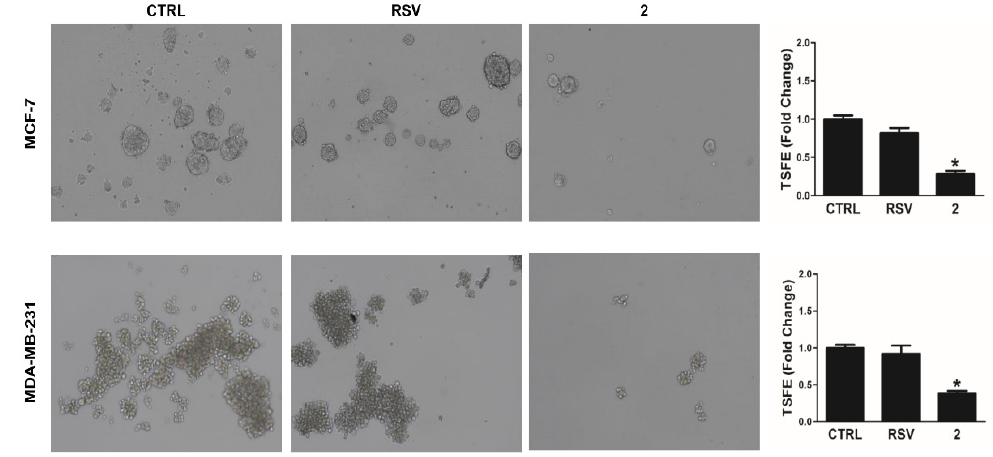
Figure 9. Derivative 2 inhibits breast cancer cell 3D-spheroid formation. MCF-7 and MDA-MB-231 cells were plated on low-attachment plates and then left untreated (CTRL) or treated with derivative 2 ( 2 ) and RSV (20 µM). Spheroid formation capability of untreated and treated cells was determined in a 3D spheroid assay as described in “Materials and Methods”. Tumor spheres formation efficiency (TSFE) was evaluated five days later (* p < 0.05 vs. untreated cells). Images are from a representative experiment (magnification × 100, scale bar: 100 µ m). Right graphs represent the mean values ± SD of three independent experiments of 3D-spheroids formed and expressed as fold change over untreated cells (CTRL) (* p < 0.05 vs. CTRL).